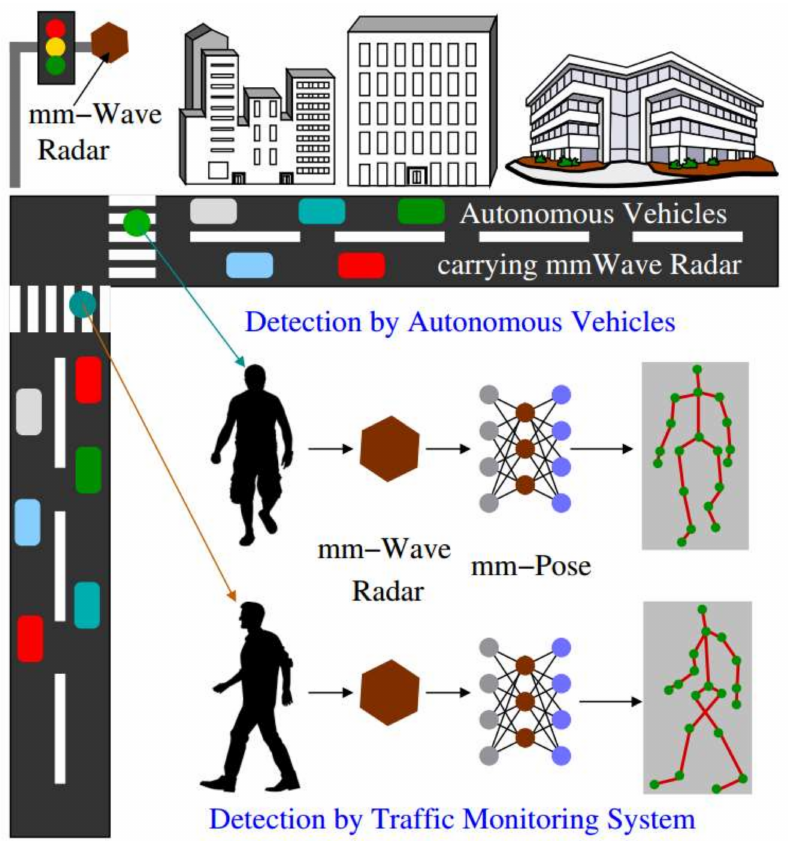
Figure 10. In automatic/semi-autonomous vehicles and traffic monitoring systems, mm-Pose can be used to perform robust skeleton pose estimation of pedestrians. Figure from